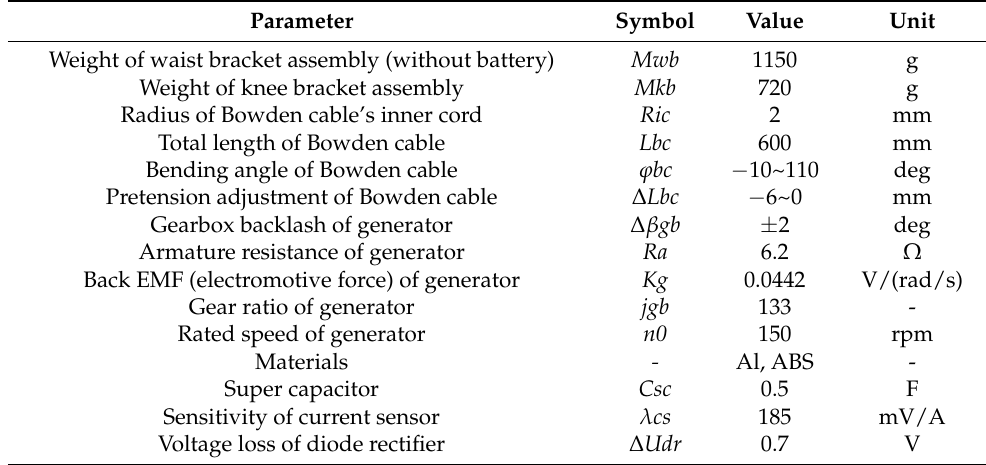
Table 3. Major parameters of Bowdencable-actuated knee exoskeleton.